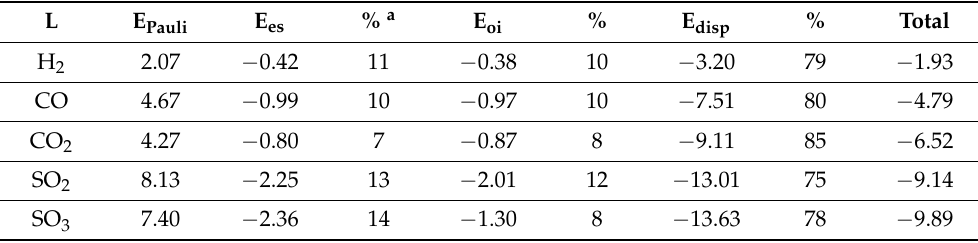
Table 3. EDA/BLYP-D3/ZORA/TZ2P decomposition of the interaction energy of C 18 complexes into Pauli repulsion (E Pauli ), electrostatic (E elec ), orbital interaction (E oi ) and dispersion (E disp ) components. All energies in